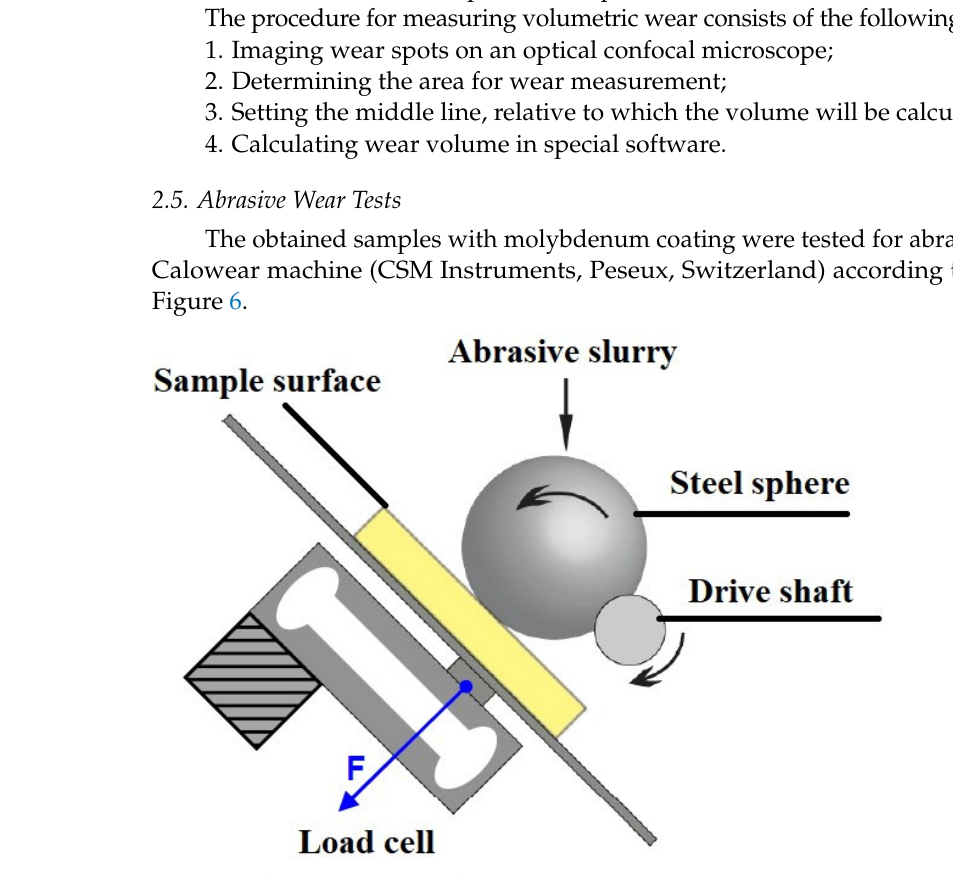
Figure 6. Abrasive wear test scheme.